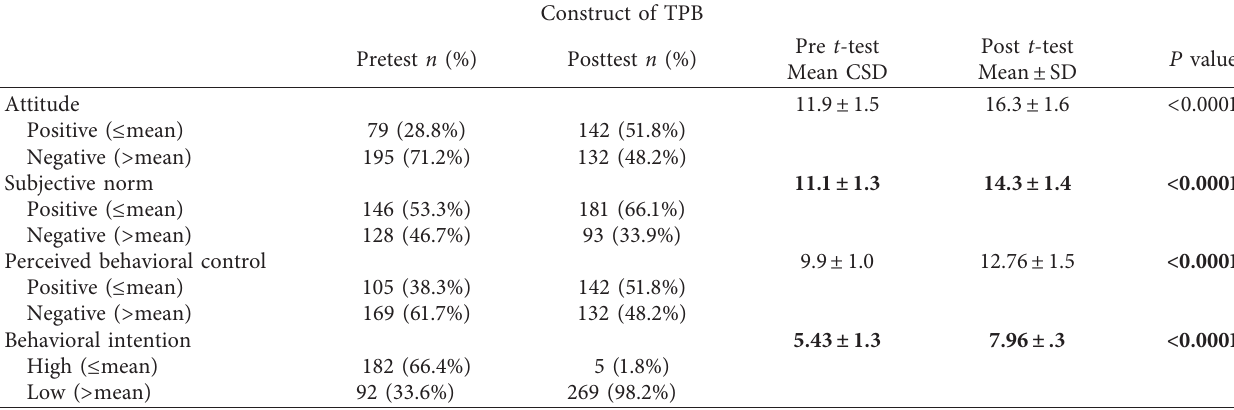
Table 3: Level of construct before and after intervention and comparing the mean score of construct of TPB before and after